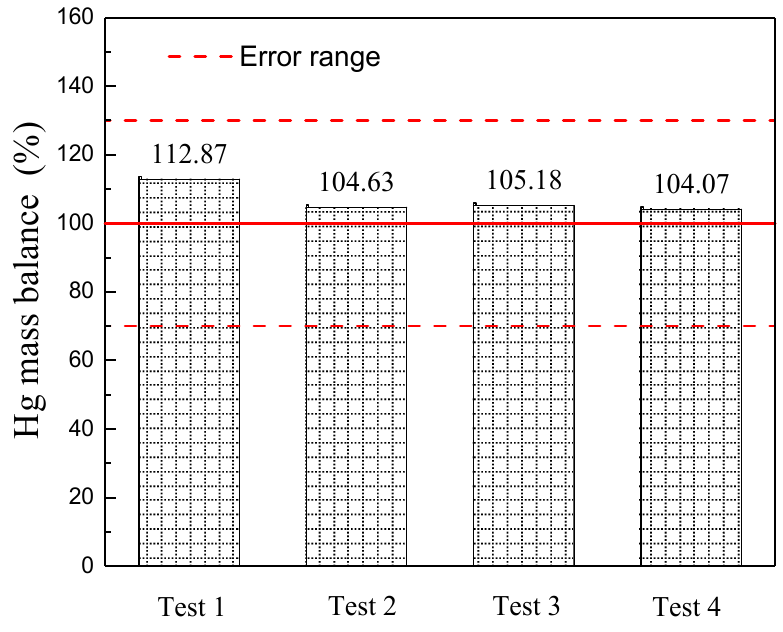
Figure 3. Hg mass balance of the four field tests.